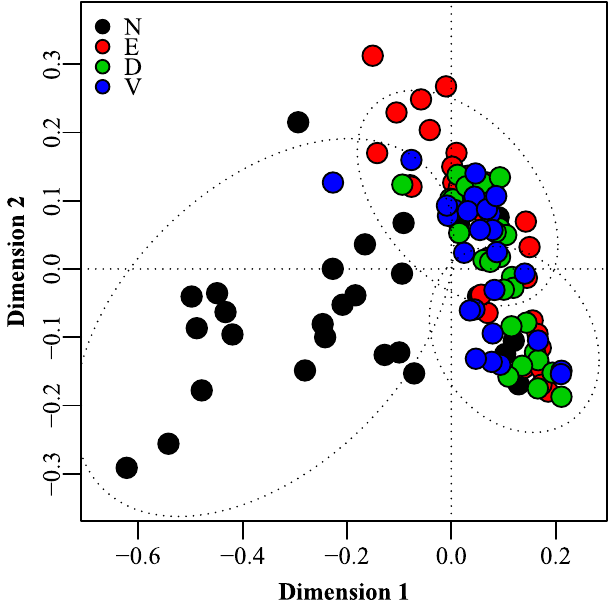
Figure 2. Principal coordinates analysis of amplicons from 16S rRNA gene sequencing. The multivariate ordination is based on the dissimilarity matrix derived from the relative abundance of bacterial genera across the samples. N: nose, E: ear, D: dorsal skin surface, V: ventral skin